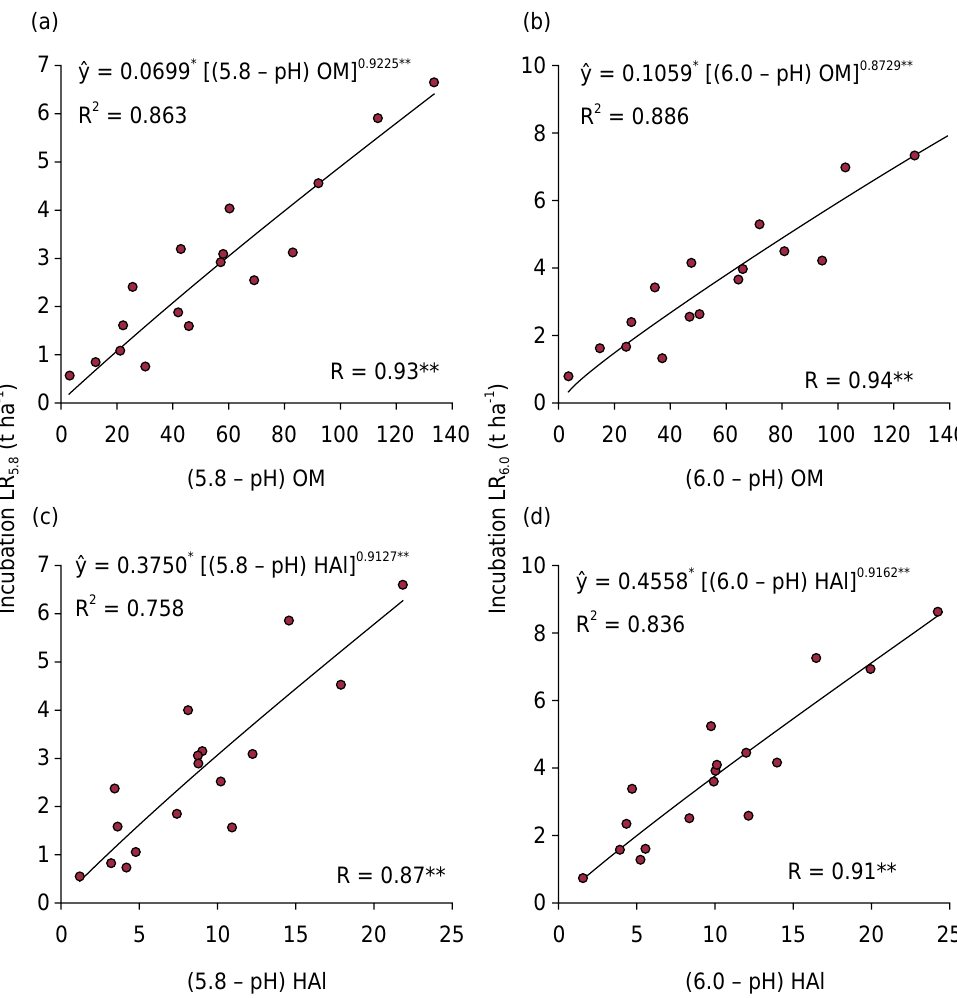
Figure 4. Relationships between lime requirement (LR) determined from the 60 d incubation to target pH values of 5.8 (a and c) or 6.0 (b and d) and combined variables consisted of changes in soil pH (target pH - initial pH) multiplied either by the level of organic matter (OM) or potential acidity (HAl). *: 0.05> p ≥0.01; **: